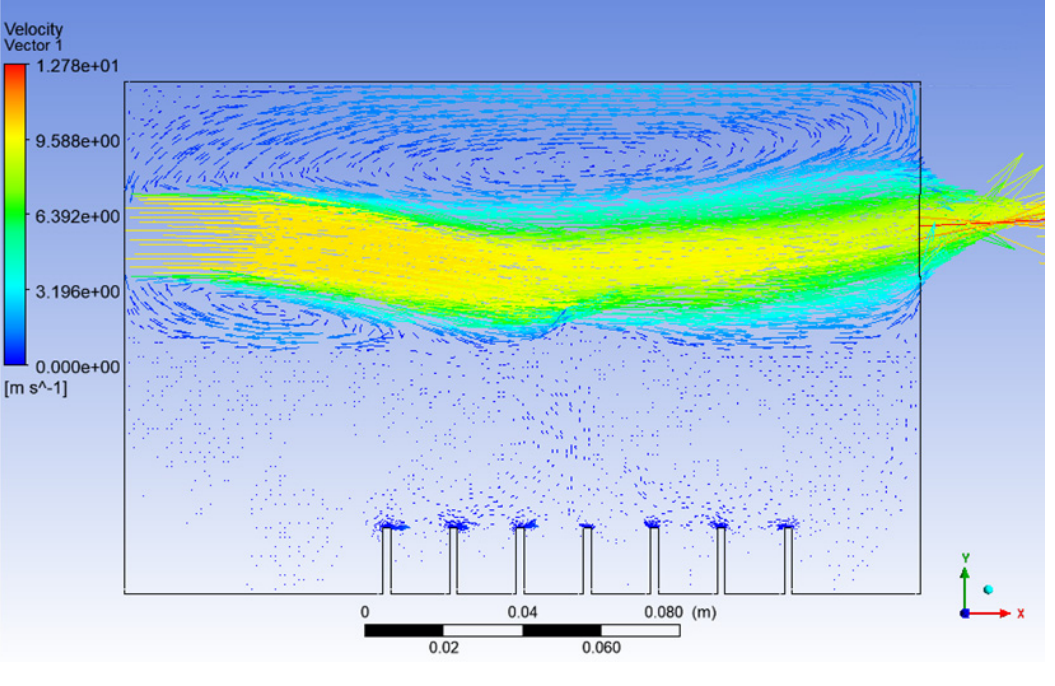
Figure 12. Velocity vector of Simulation 4.